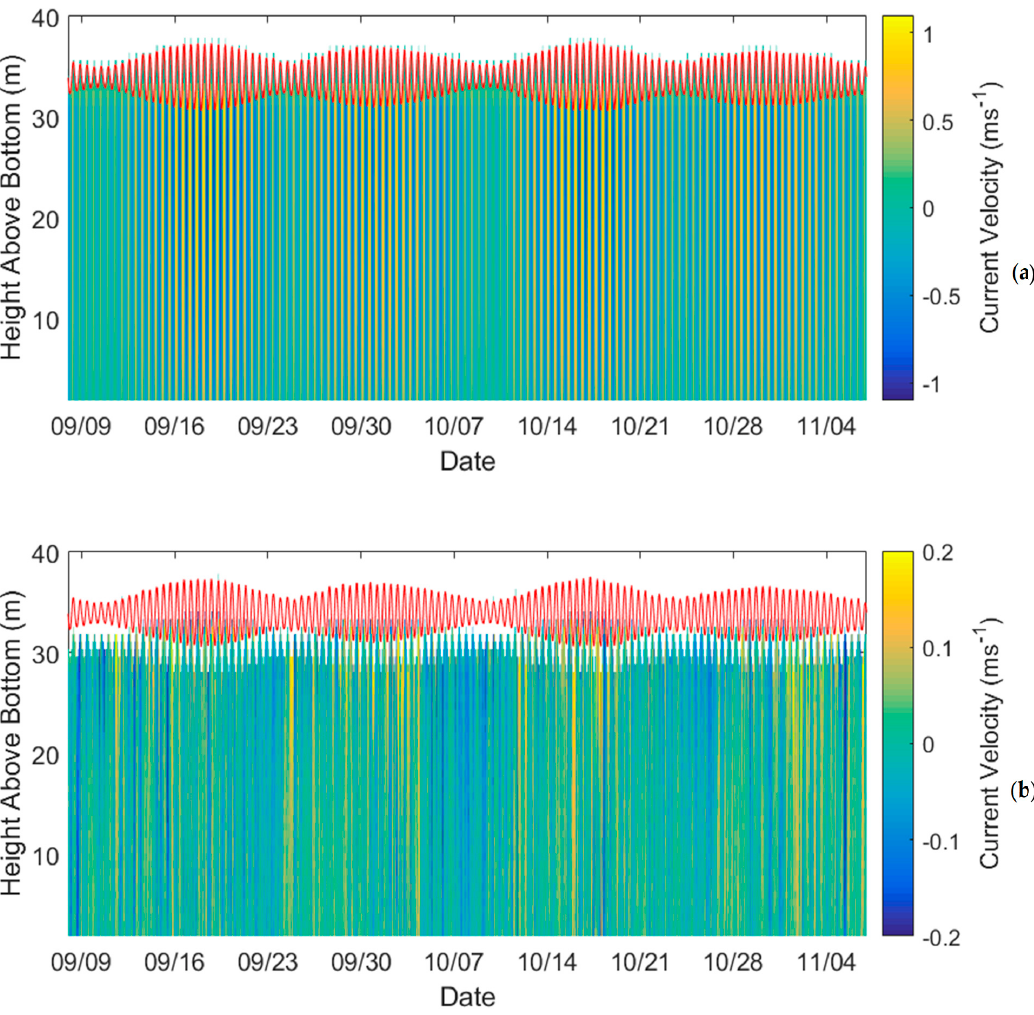
Figure 4. ( a ) Plot of the predicted current velocity throughout the water column. ( b ) Error between the predictions and measured data. Red line = water depth. Top 10% is white despite the ANNs prediction as the data were removed in the ADCP comparison due to sidelobe interference.